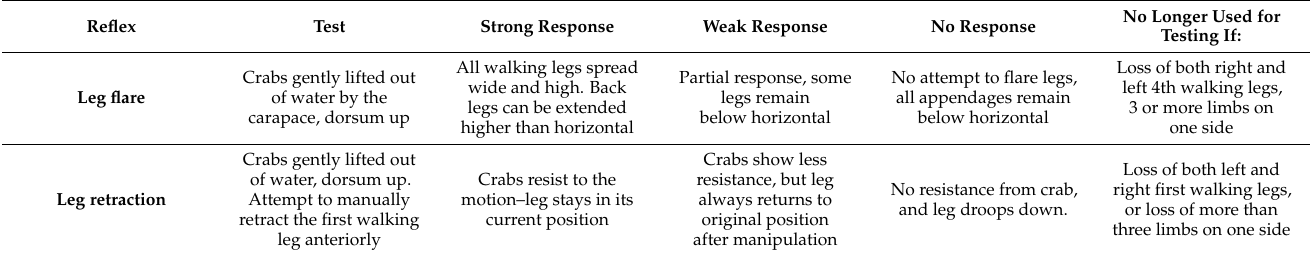
Table 1. Behavioural reflex reaction indicators used to quantify C. maenas vitality over time. Measure- ments were taken every two weeks and recorded as either strong, weak or no response. Adapted from [35]. Strong Response Weak Response No